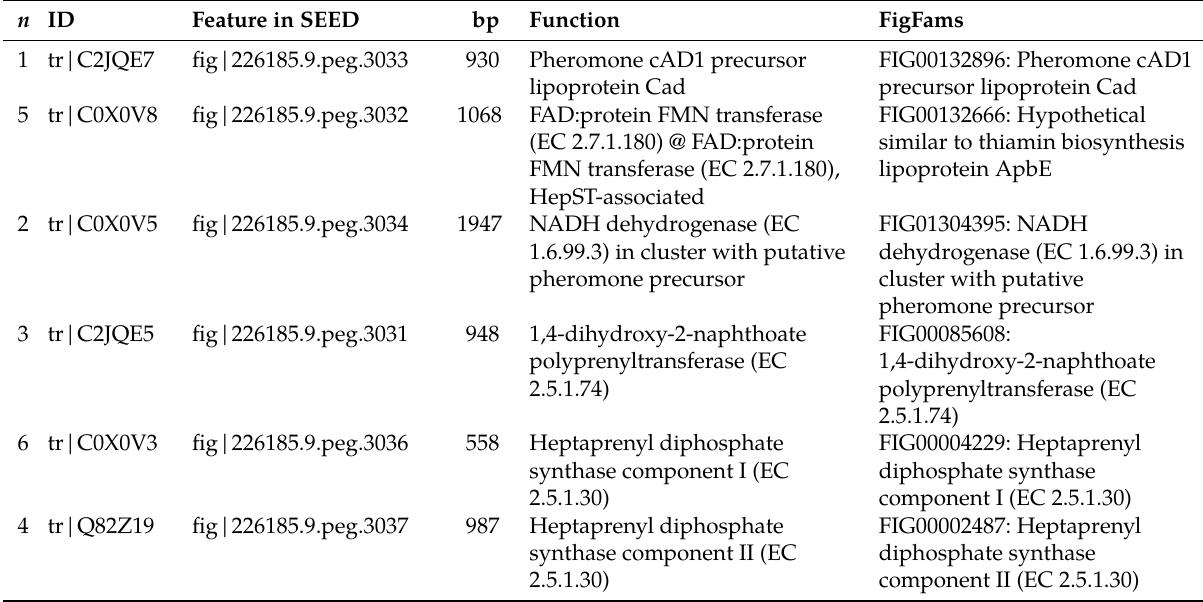
Table 1: Annotations and associated IDs for genes in cAD1 precursor/cad locus in Enterococcus faecalis V58